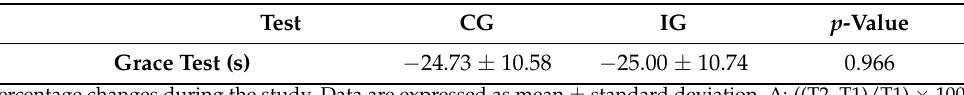
Table 4. Percentage changes during the study on Workouts of the Day (WODs) in the two study groups: control group (CG) and intervention group (IG). Reproduced with appropriate permissions from Ref. [17]. Copyright 2021 Fern á ndez-L á zaro, Diego. https://www.mdpi.com/2072-6643/13/1 1/3969 (accessed on 10 August